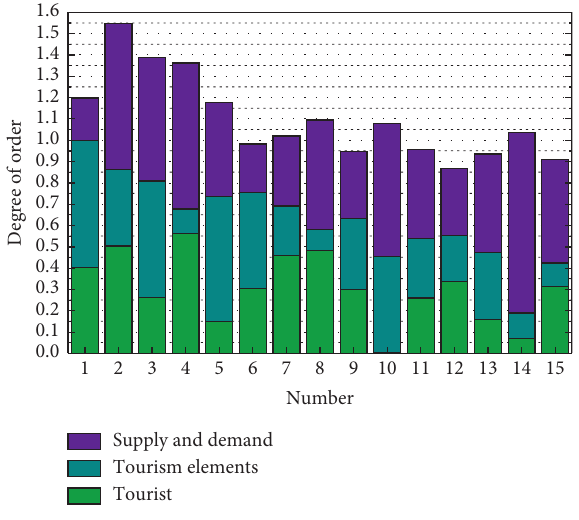
Figure 8: Orderliness score of each